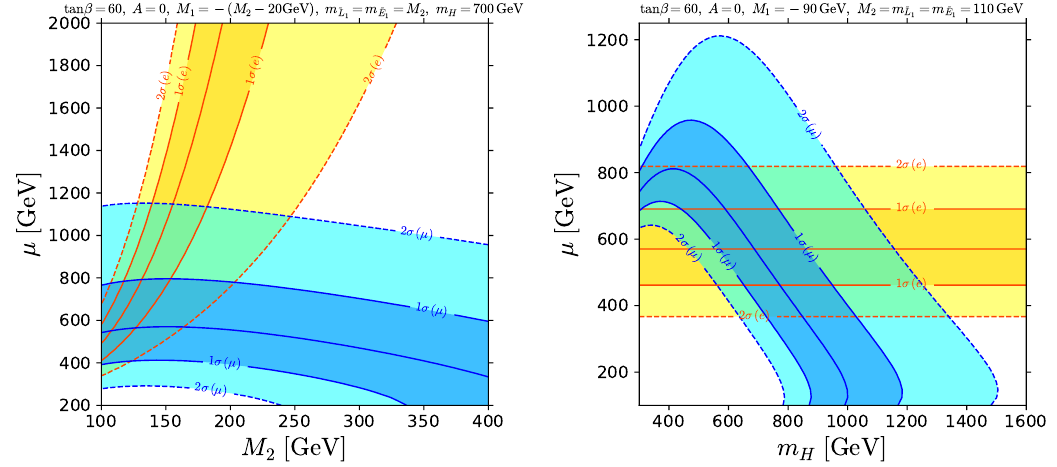
Figure 5 . Left panel: the same as in (cid:12)gure 2 but in the scenario motivated by the Higgs mediated SUSY breaking with m H = 700 GeV. Right panel: the same as in (cid:12)gure 3 but in the (cid:22) { m H plane. In (cid:12)gure 4 we show R ’s as a function of m . The selectron, wino and bino soft H l